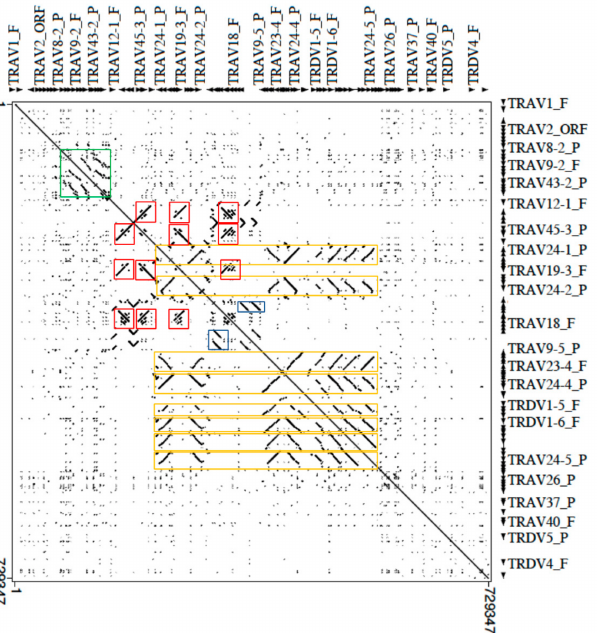
Figure 4. Dot-plot matrix of the dromedary V-cluster sequence against itself. With the exception of the main diagonal line for the match of each base with itself, dots and lines indicate internal homology units in the sequence. The colored boxes show that the V region underwent to duplication events (see text). Orthogonal lines indicate units of homology between regions with an opposite